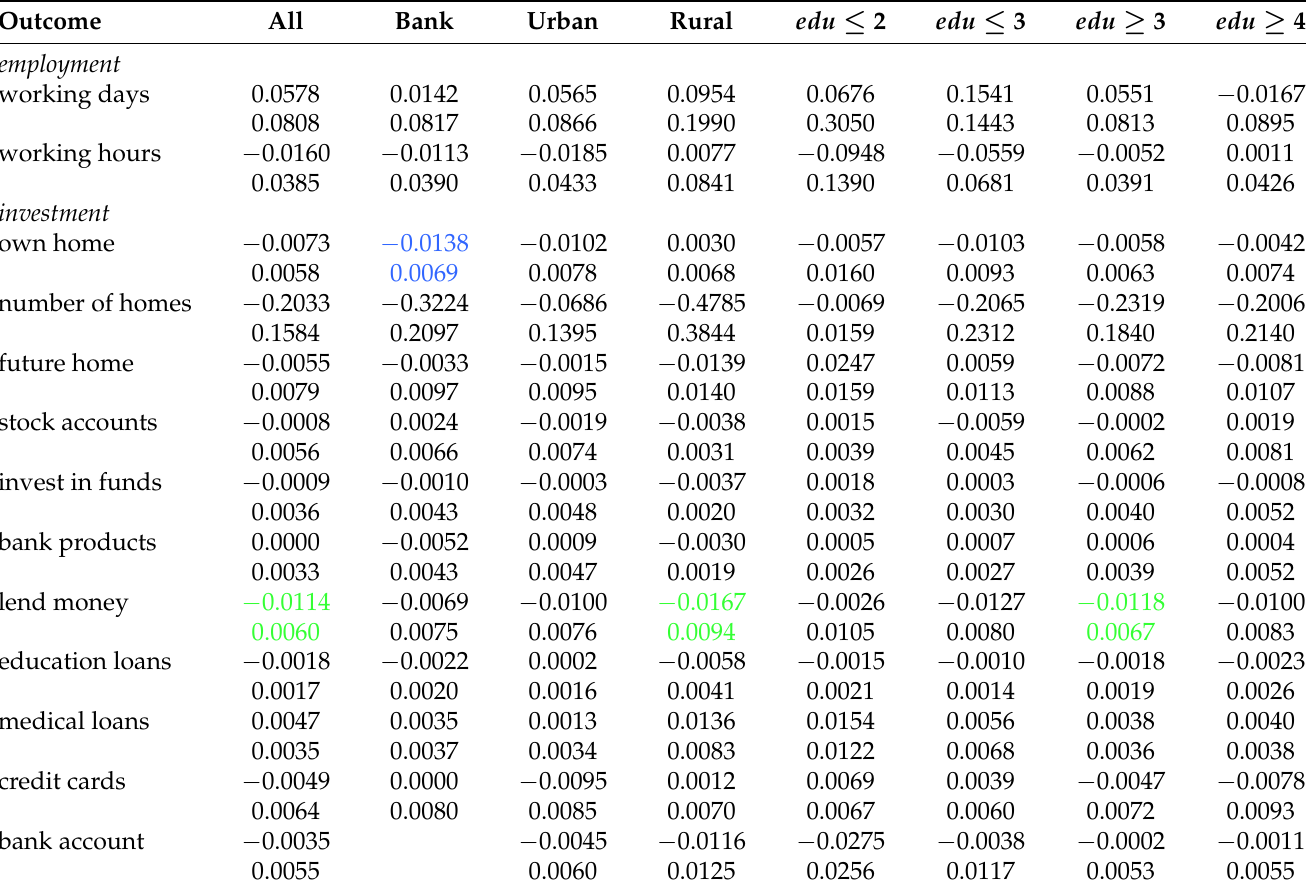
Table 4. ATET estimates (with their corresponding standard error beneath) for all treated vs. all control provinces for both employment and investment outcomes (units of measurement are further described in Table 1): For all families and for families whereby (1) someone has a bank account, (2) reside in an urban or (3) reside in a rural area, and by (4) education level ( < 2 primary school or below, ≤ 3 junior high or below, ≥ 3 junior high or above, and ≥ 4 high school or above)—Significance of point estimates at the arbitrary 1, 5, and 10 percent levels are colored red, blue, and green,